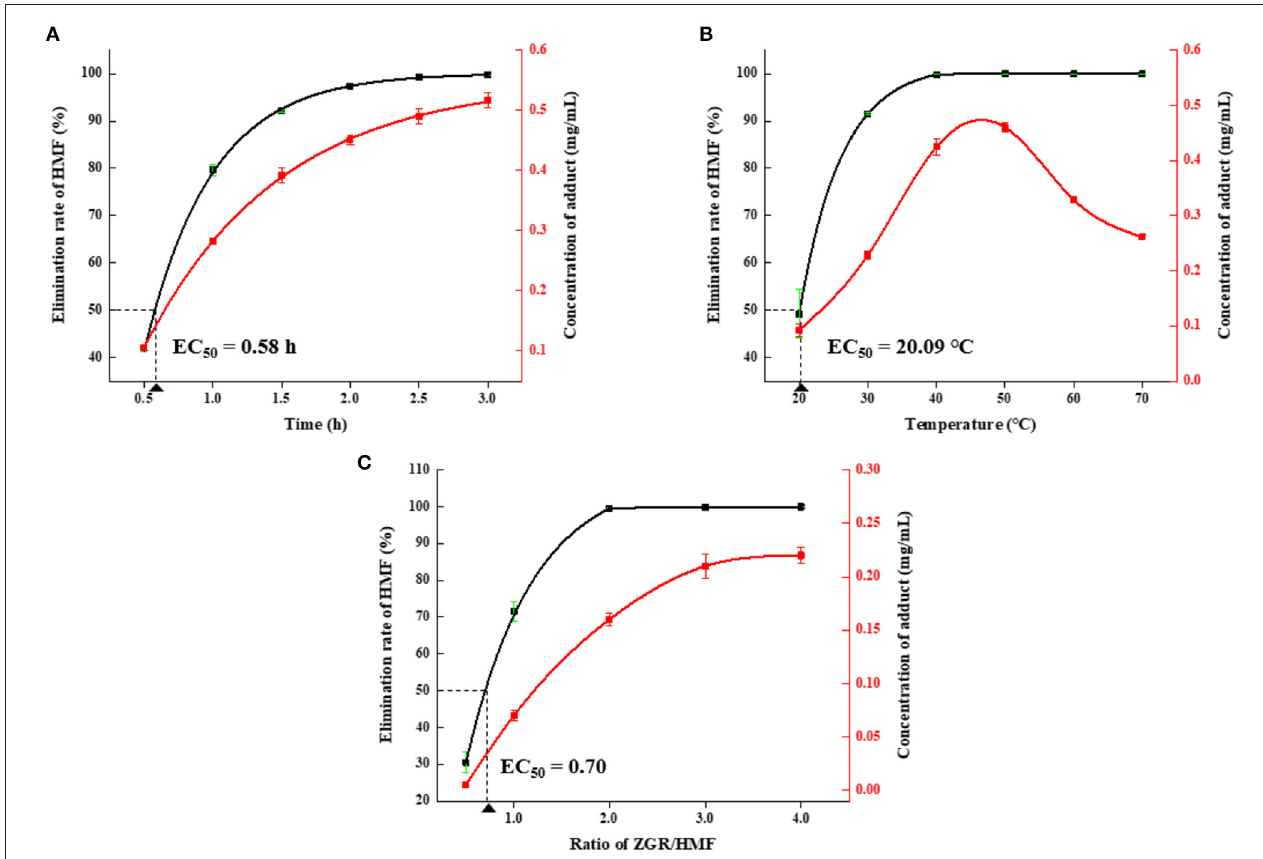
FIGURE 3 | The effects of different (A) reaction times, (B) temperatures, and (C) molar ratios on elimination of HMF and formation of HMZ. Error bars represented the standard deviation of the average of three